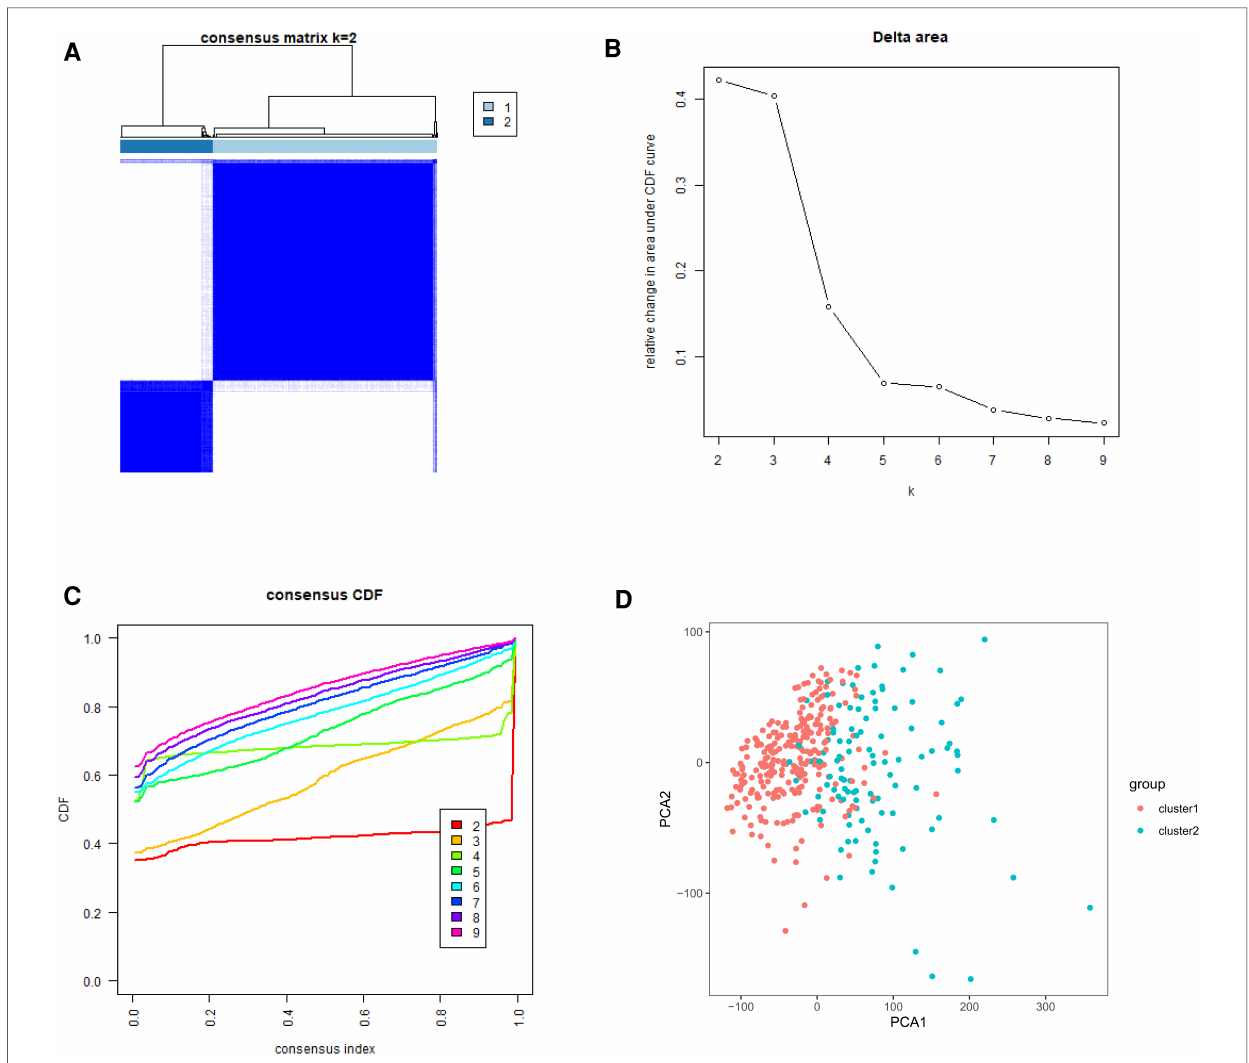
FIGURE 2 Tumor classi fi cation and veri fi cation based on m6A methylation-related genes. ( A ) The HCC patients divided into two distinct clusters, k =2. ( B ) Consensus clustering cumulative distribution function for k =2 – 9. ( C ) Relative change in area under cumulative distribution function curve for k =2 – 9. ( D ) the principle components analysis based on the m6A methylation-related